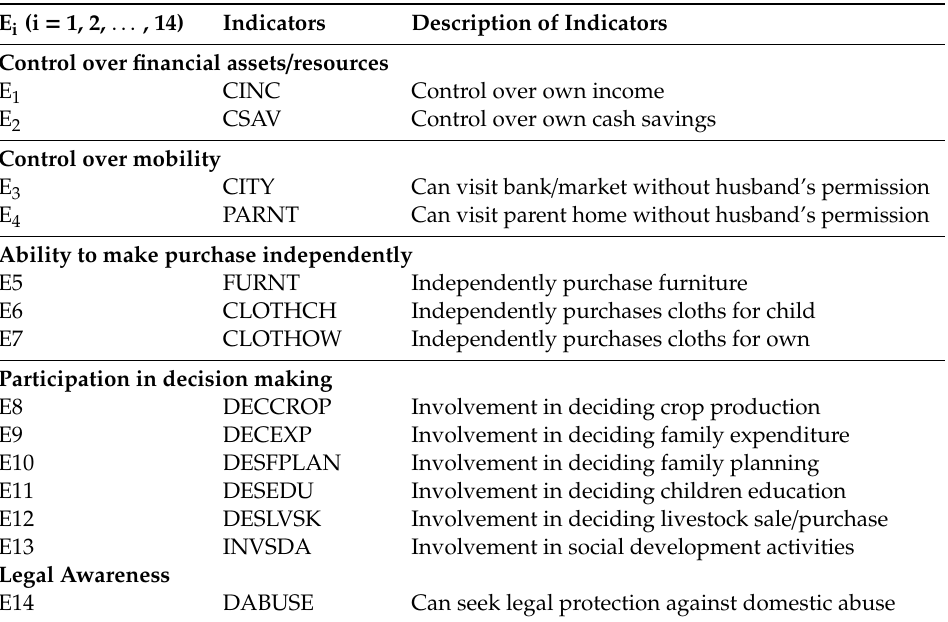
Table 2. Women empowerment